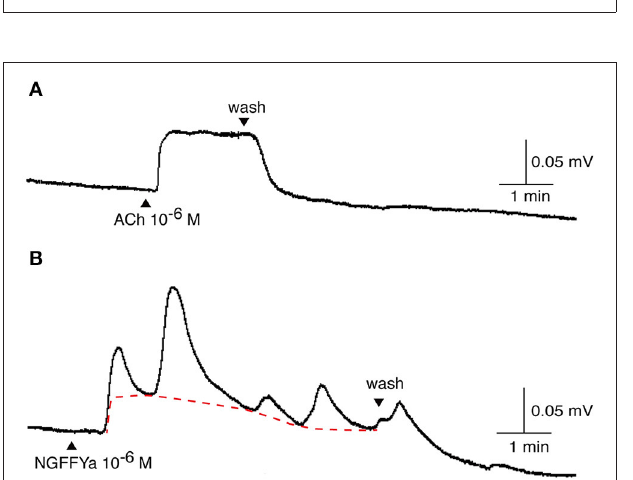
FIGURE 8 | Application of NGFFYamide to in vitro tube foot preparations from A. rubens triggers phasic contractions that are superimposed upon an increase in basal tone. Representative recordings from a single tube foot preparation are shown, comparing the effect of (A) acetylcholine (ACh; 10 − 6 M) and the effect of (B) NGFFYamide (10 − 6 M). Application of ACh and NGFFYamide are labeled with upward pointing arrowheads and washing of the preparation is labeled with a downward pointing arrowhead.